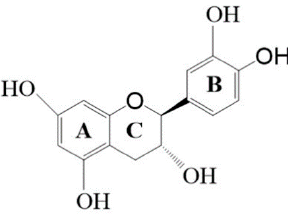
Figure 1. The molecular structure of (+)-catechin.